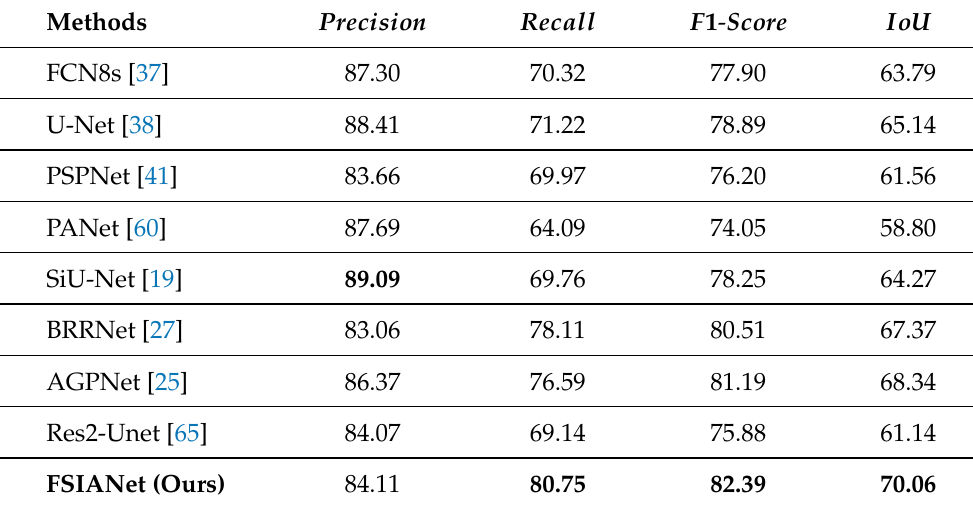
Table 2. Quantitative results on Precision , Recall , F 1- Score , and IoU (in %) of different methods on the East Asia Dataset. The best results are shown in